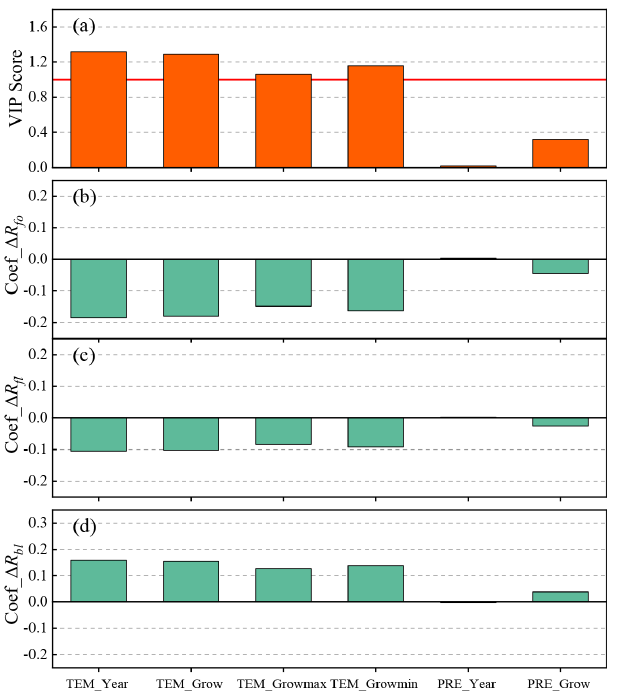
Figure 12. Relationship between the forest cover and forest type changes and climate variables for 5-year intervals obtained using PLS regression models: (a) VIP scores; panels (b) , (c) and (d) show the corresponding standardized regression